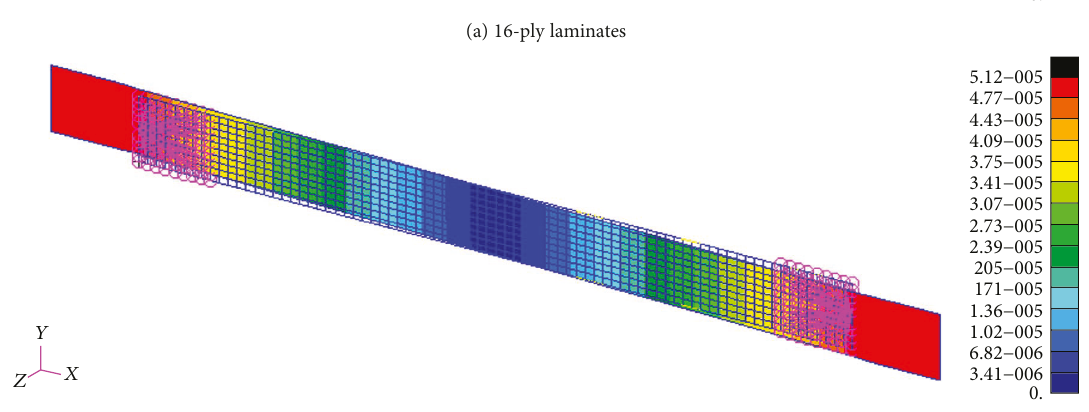
Figure 5: Deformation of two kinds of hybrid A